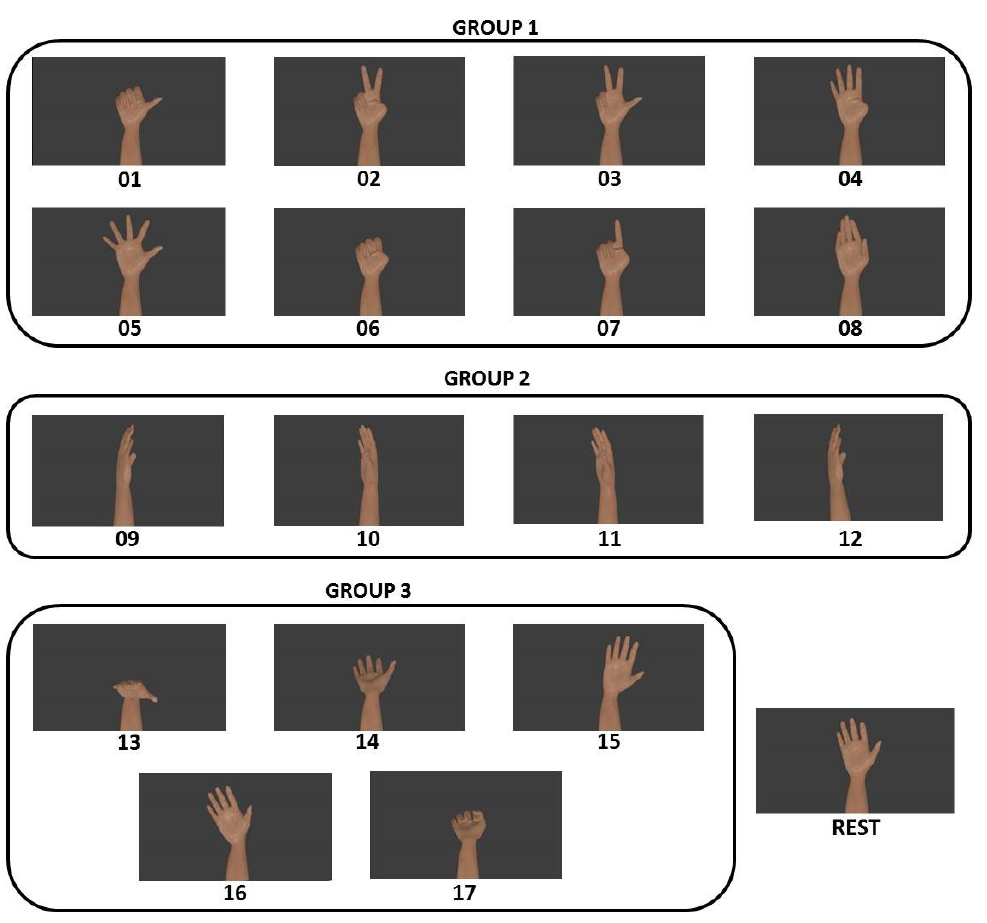
Figure 1. The three different groups of movements performed by each subject in the